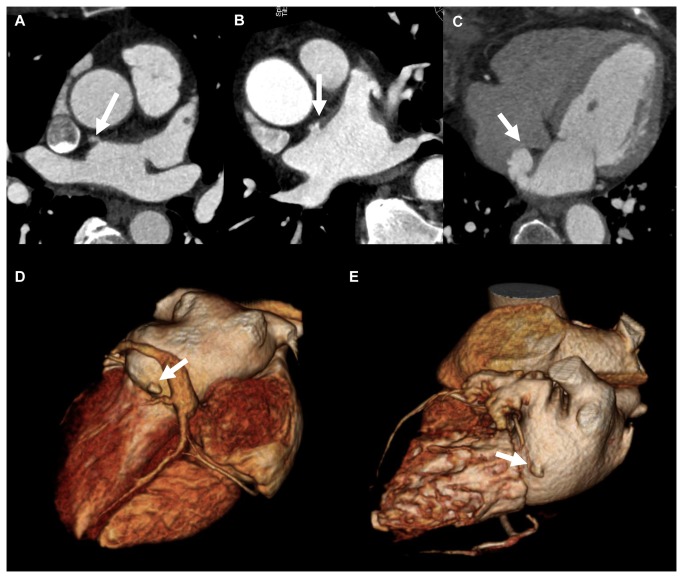
Location of LA out-pouching structures was divided into five categories: (A) near Bachmann bundle, (B) anterior, (C) inferoseptal, (D) inferior, and (E) lateral.